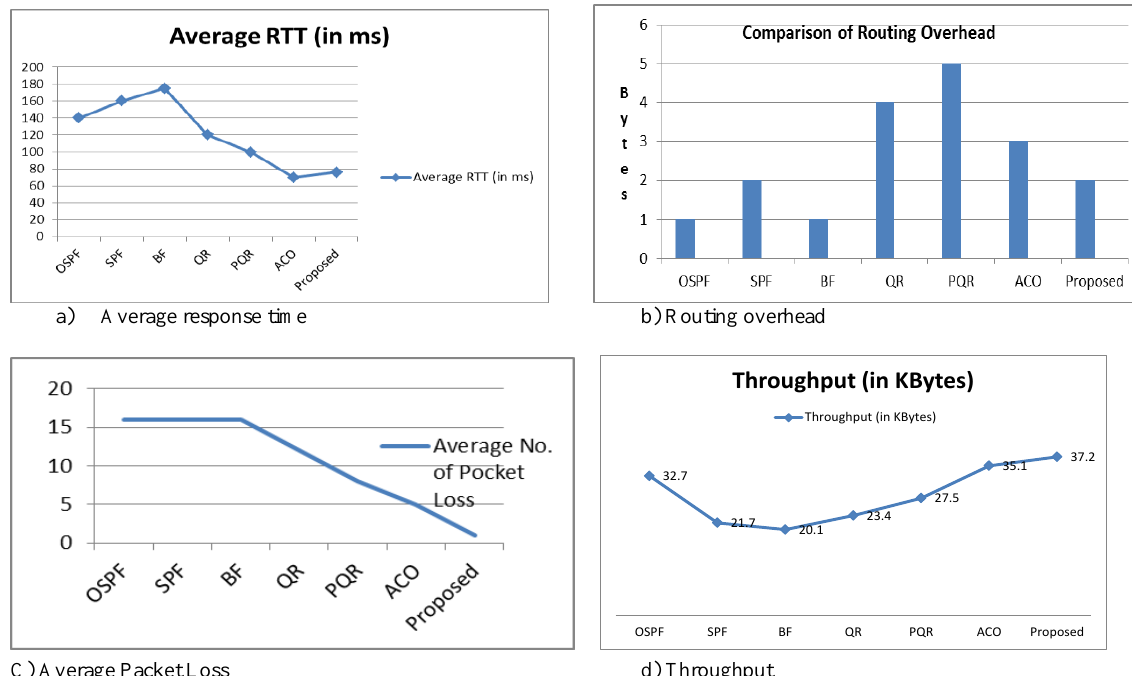
Fig 4 Performance comparison between various routing algorithms with Proposed System (10 wired, 20Wireless and 5Mesh Nodes in heterogeneous network environment) // J (r ) is the set of yet to be visited cities for k k1 //ant k in city r